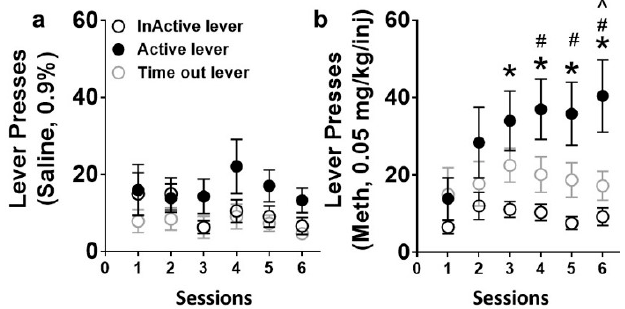
Figure 2. Self-administration data from saline ( a ) and methamphetamine ( b ) rats. ( a ) Active, inactive, and timeout lever responses during extended 6 h access sessions of saline self-administration. ( b ) Active, inactive, and timeout lever responses during extended 6 h access sessions of methamphetamine self-administration. n = 9 saline and n = 20 methamphetamine rats. Data are expressed as mean ± standard error of the mean (SEM). * p < 0.05 vs. inactive lever responses, ˆ p < 0.05 vs. timeout lever responses, # p < 0.05 vs. session 1 by repeated-measures ANOVA.